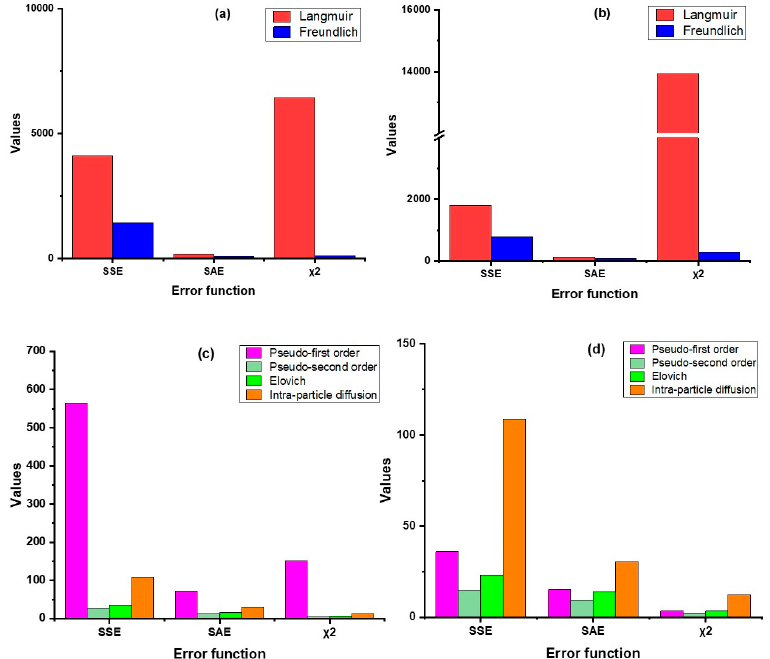
Figure 4. Error analysis of isotherm models (linear ( a ) and non-linear ( b )) and kinetic models (linear ( c ) and non-linear ( d )) for nZVI-Bento. SSE, error sum of squares; SAE, sum of absolute error; χ 2 , chi-square; AICc, corrected Akaike Information Criterion.